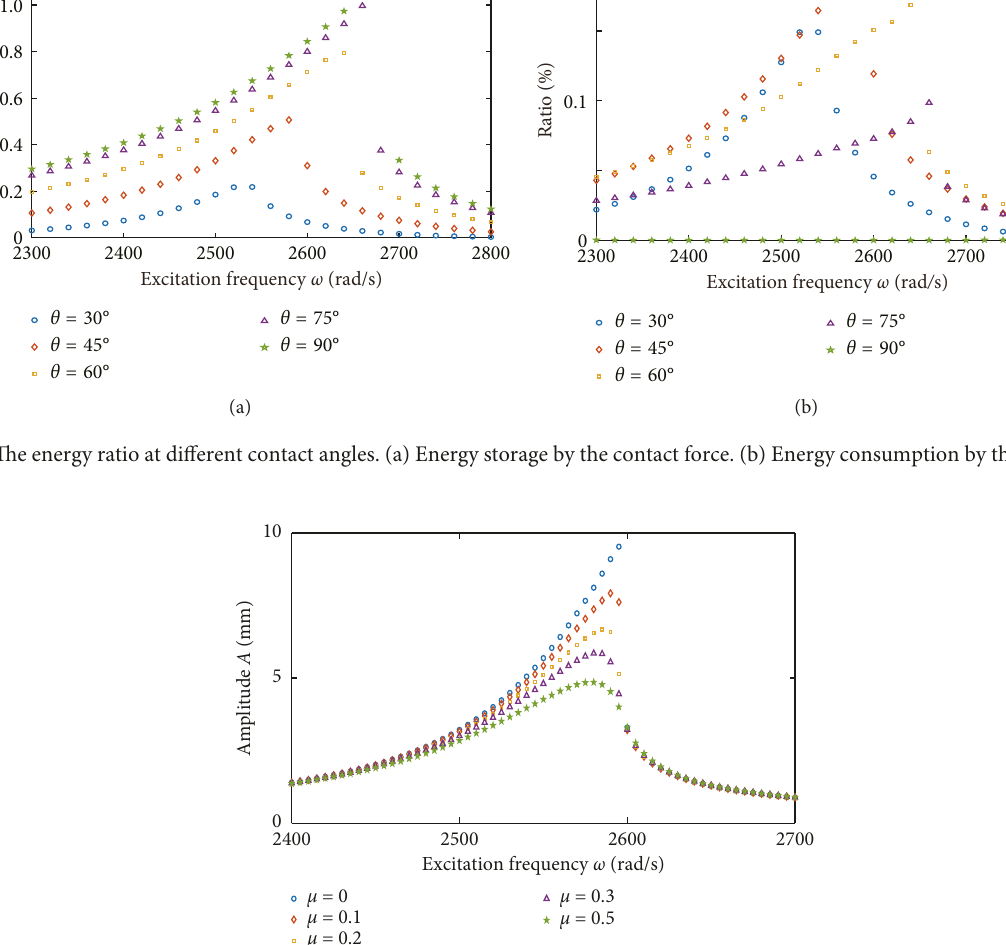
Figure 10: The amplitude-frequency curves at different friction coefficients.